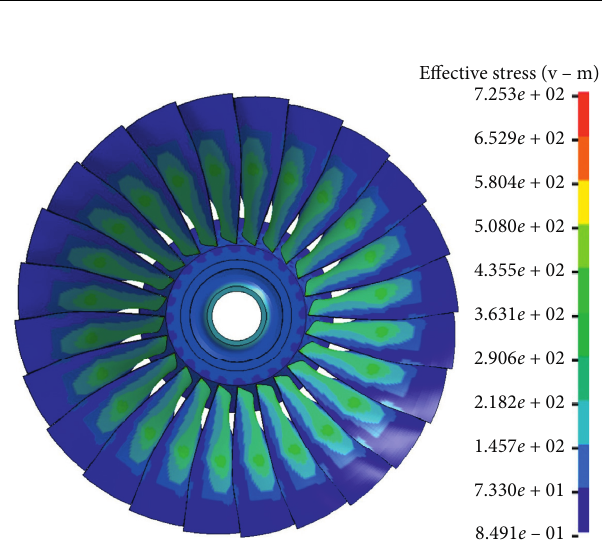
Figure 8: von Mises stress (MPa) of the fan assembly.